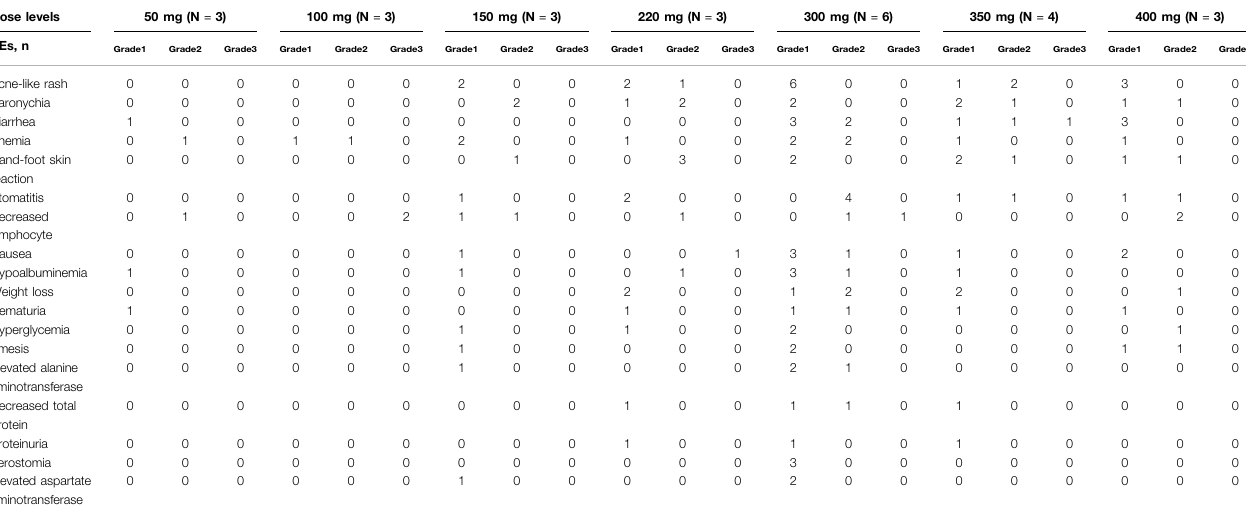
Frontiers in Pharmacology |